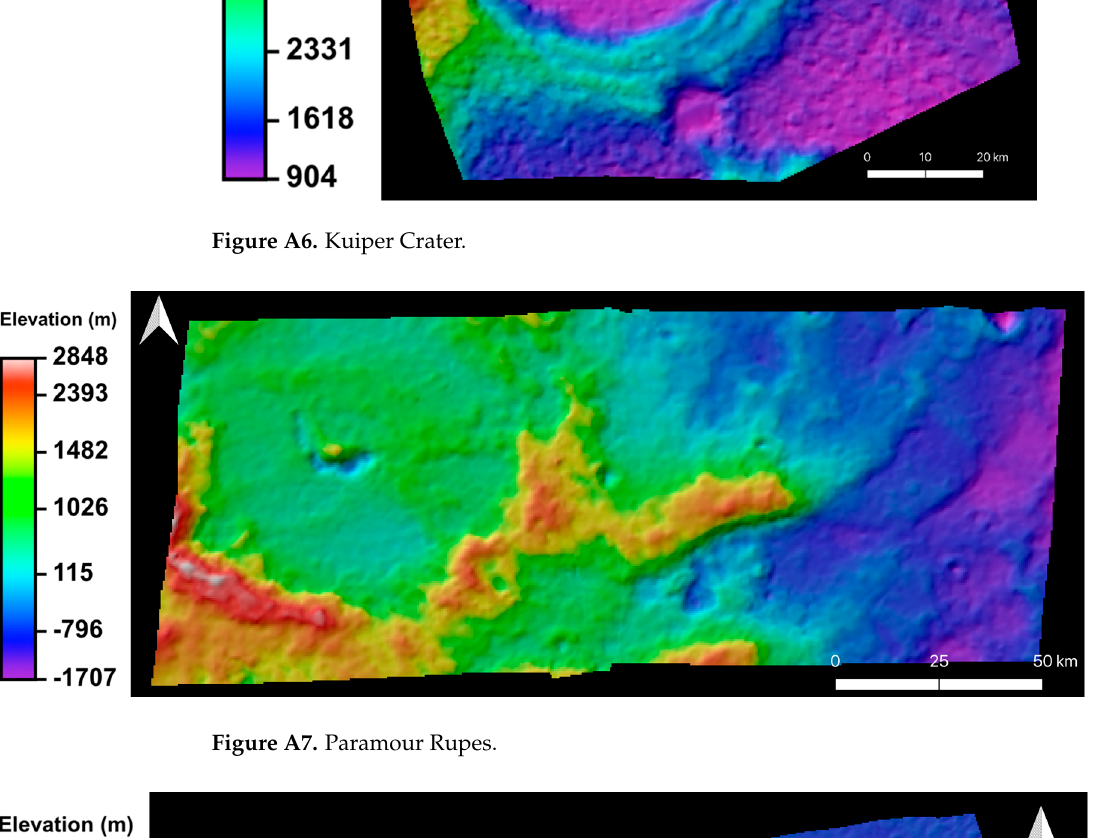
Figure A7. Paramour Rupes.